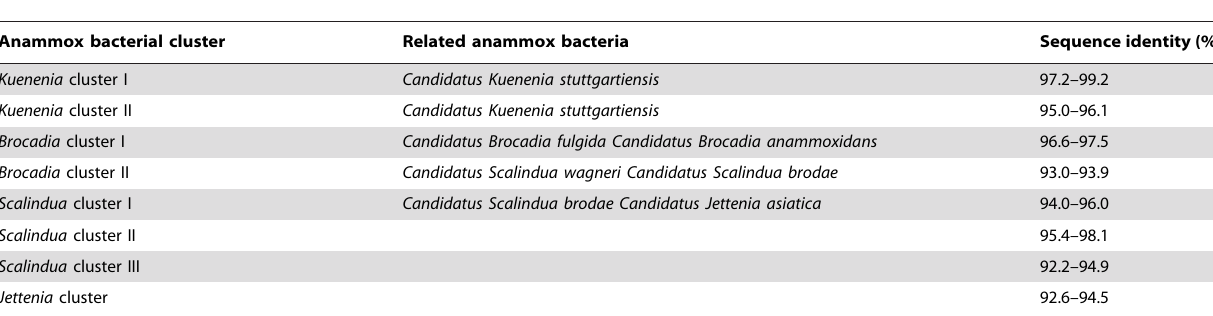
Table 4. Sequence matches between each cluster and known anammox bacteria.